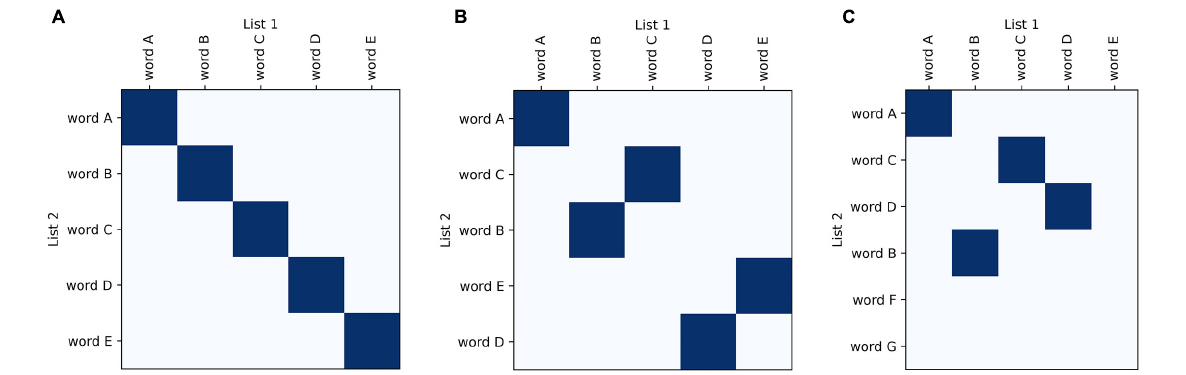
Frontiers in Aging Neuroscience |